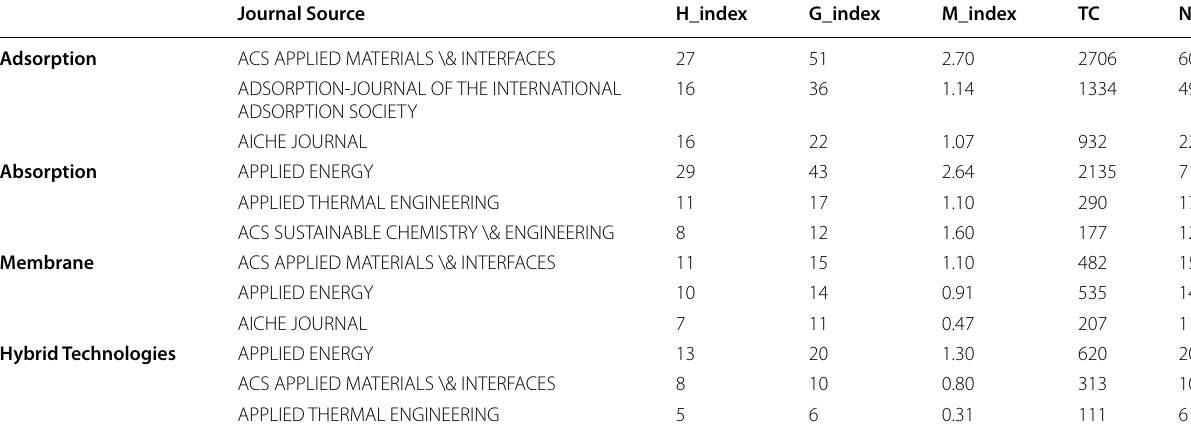
Table 4 Journal index rankings, base technologies